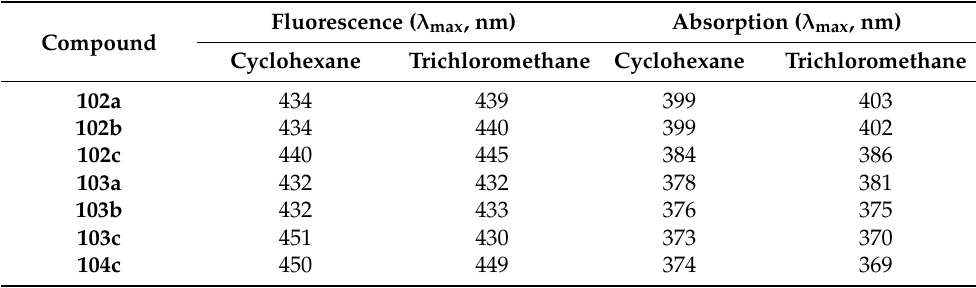
Table 17. λ max (nm) of absorption spectra and λ max (nm) of emission spectra of compounds 102a – c , 103a – c and 104c